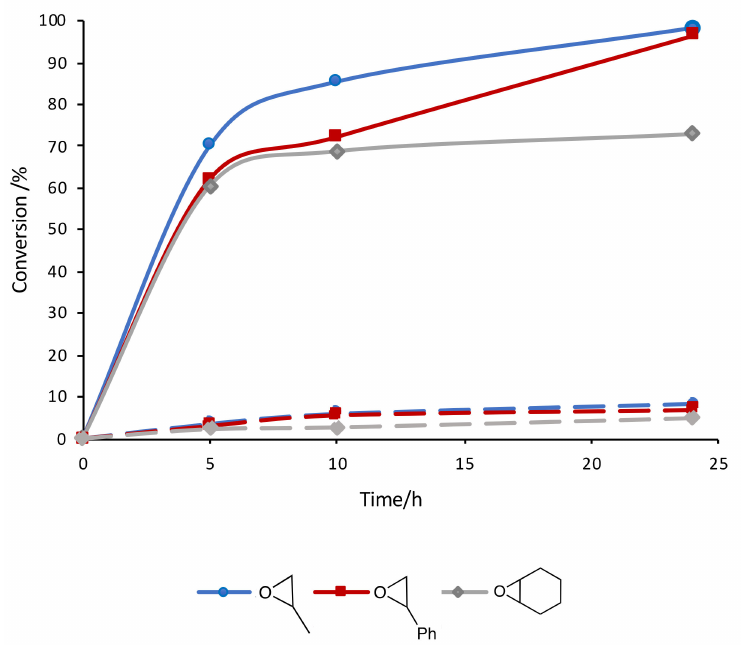
Figure 3. Kinetic profile of the cycloaddition of CO 2 to different epoxides catalyzed by the [FeCl 2 { κ 3